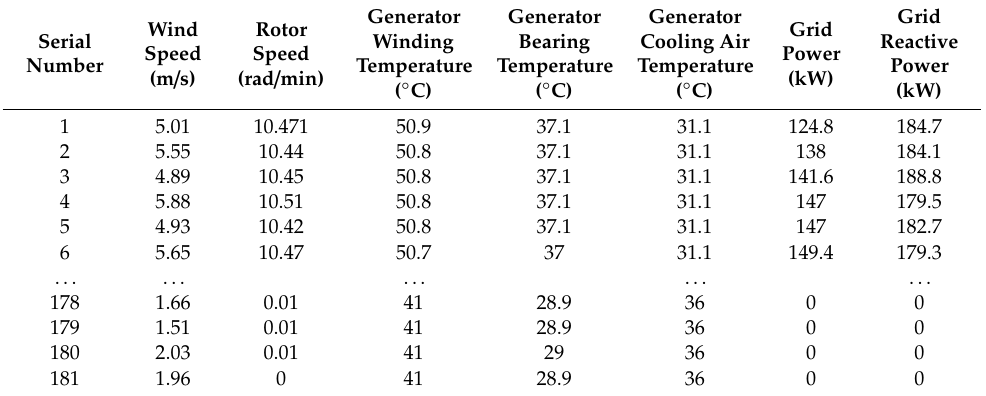
Table 9. SCADA system indicator variable data when the system is in converter faulty operation.